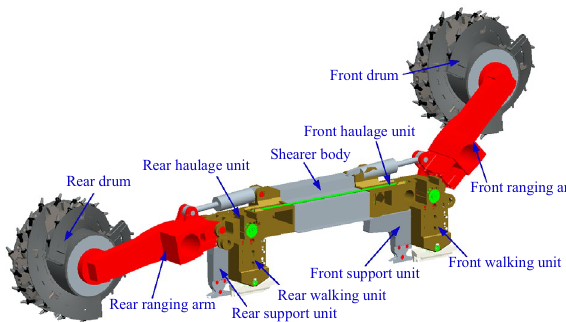
Figure 1. Three-dimensional schematic of the coal shearer.